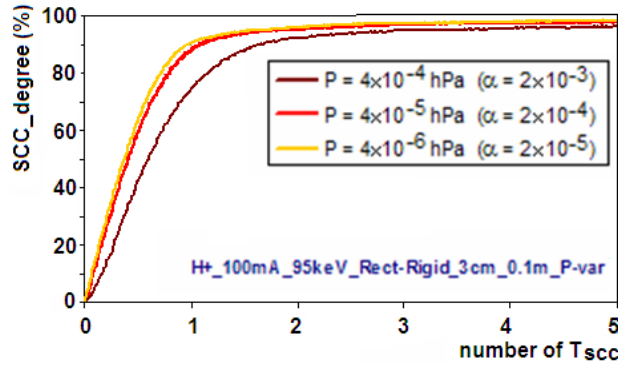
FIG. 2. (Color) SCC degree of the H (cid:1) beam at 4 (cid:7) 10 (cid:2) 4 , 4 (cid:7) 10 (cid:2) 5 , and 4 (cid:7) 10 (cid:2) 6 hPa . Plots are normalized as a function of T SCC